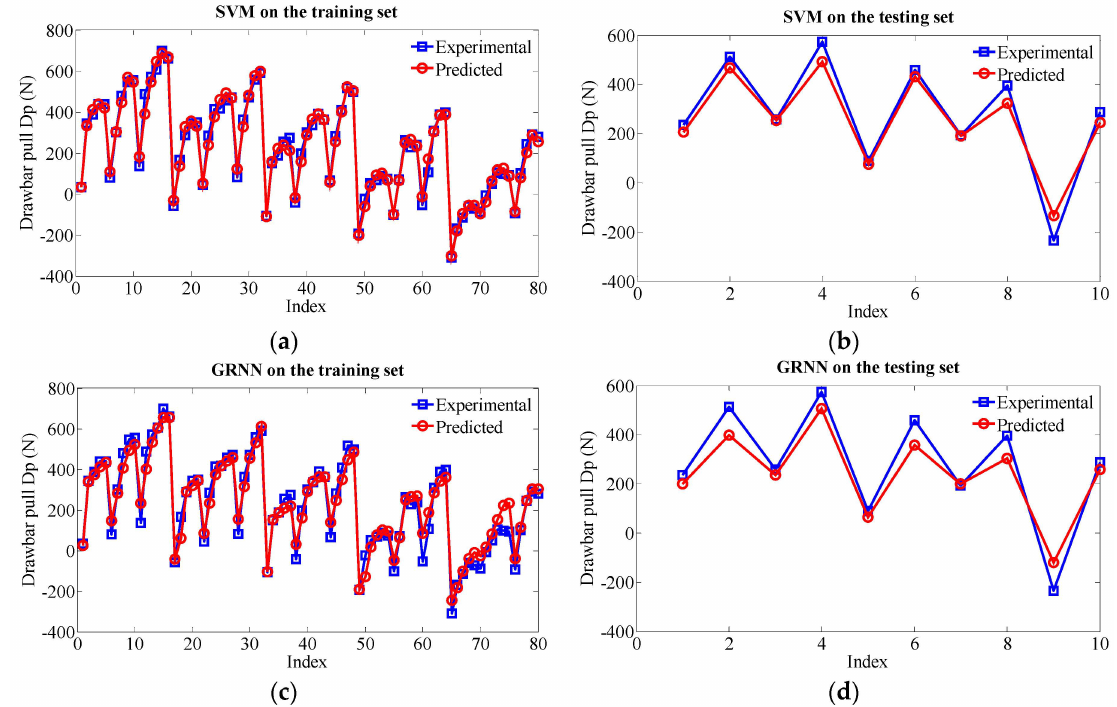
Figure 14. Prediction results of the SVM model and GRNN model on the training set and the testing set. ( a ) SVM on the training set; ( b ) SVM on the testing set; ( c ) GRNN on the training set; ( d ) GRNN on the testing set.